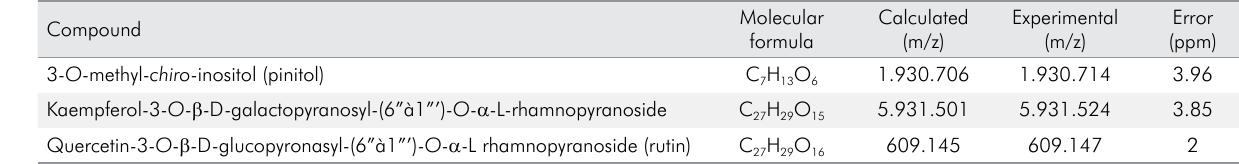
Table 1. Proposed identification of molecules and mass data for crude extract from leaves of G. graciliflora .